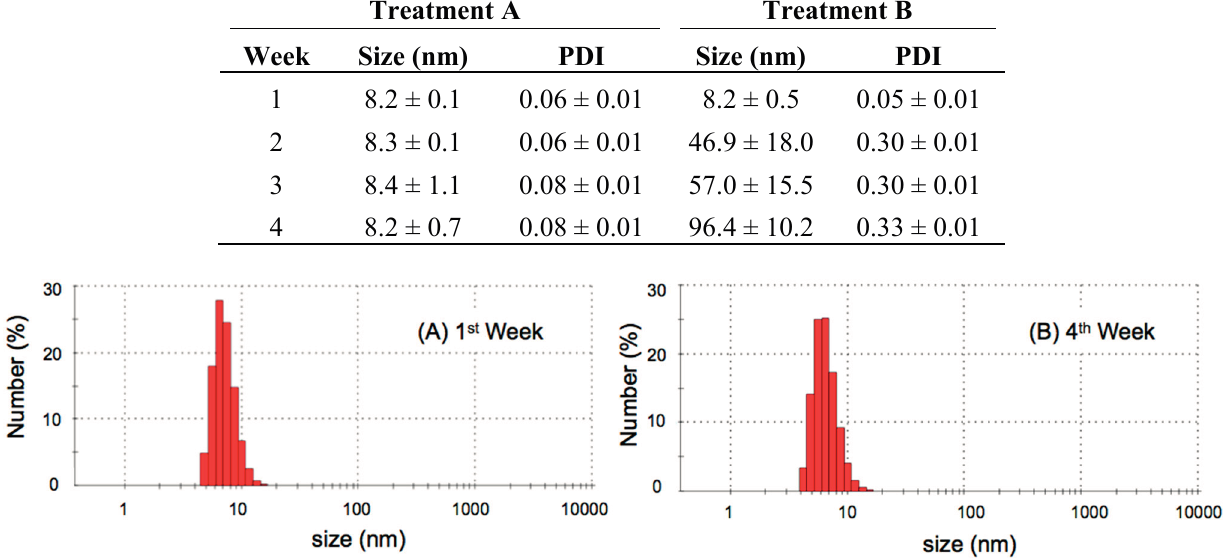
Figure 2. Typical DLS measurements for biflorin micellar structures during the first week ( A ) and fourth week ( B ), after preparation (Treatment